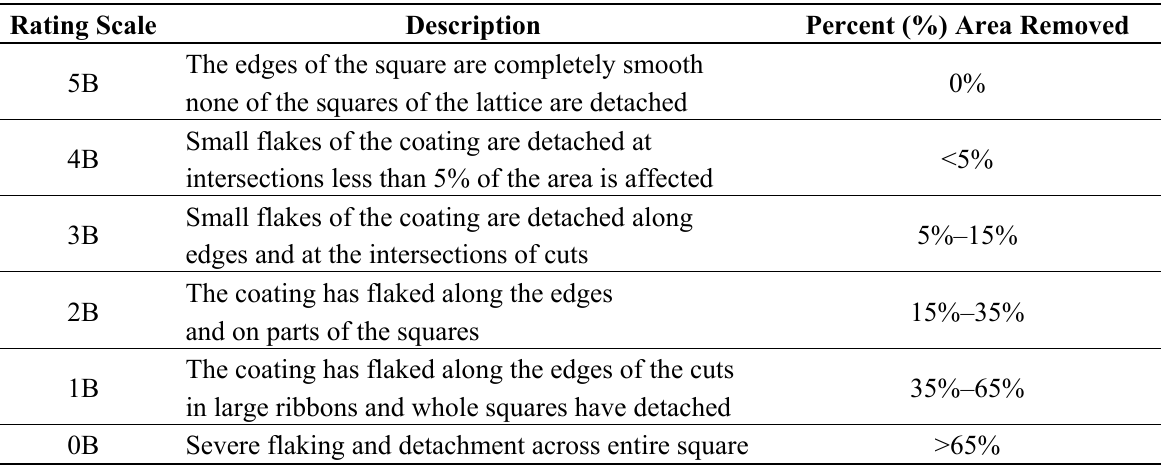
Table 2. ASTM D 3359 Method B, Crosshatch adhesion rating scale with description and percent (%) area